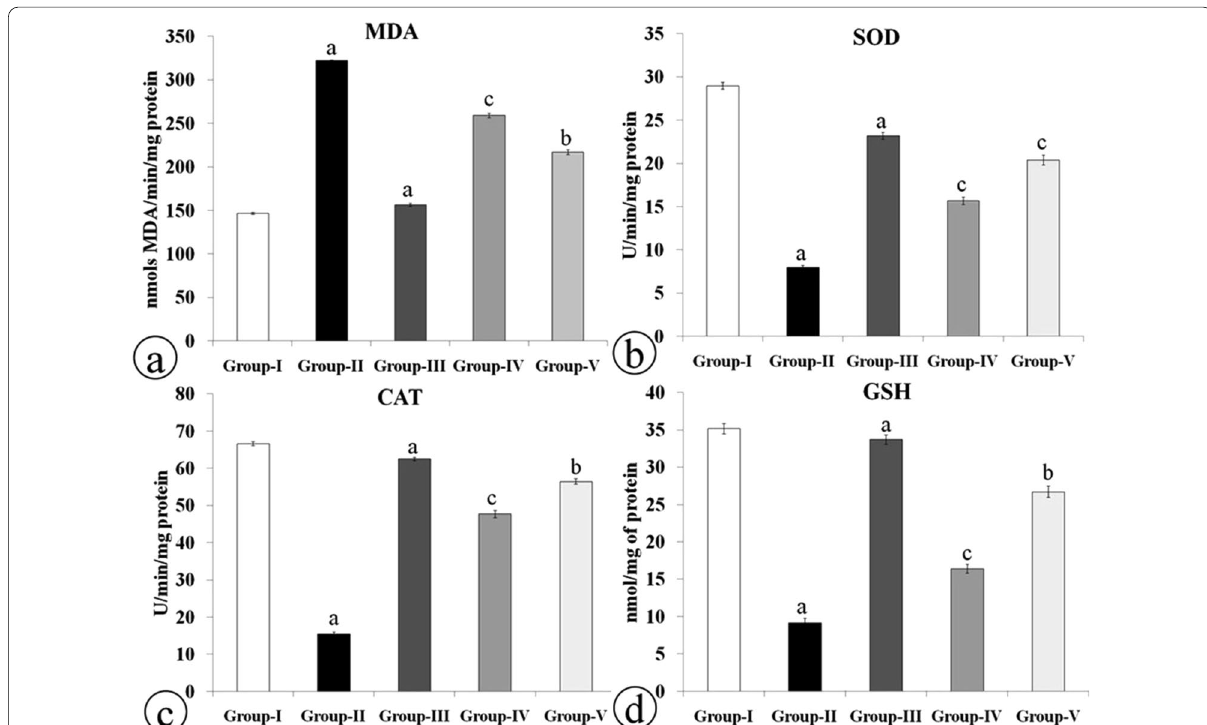
Fig. 4 Effects of ethanolic extract of L. rugosa on antioxidant enzymes activity and liver malonaldehyde content of CCl 4 toxicity rats. Values are expressed as mean SEM, n 6 and were estimated using one-way ANOVA followed by post hoc Tukey HSD test. Comparisons are made between ± = (1) Group-I versus Group-II, (2) Group-II versus Group-III, IV and V. c p ˂ 0.05, b p ˂ 0.01, a p ˂ 0.001 considered as